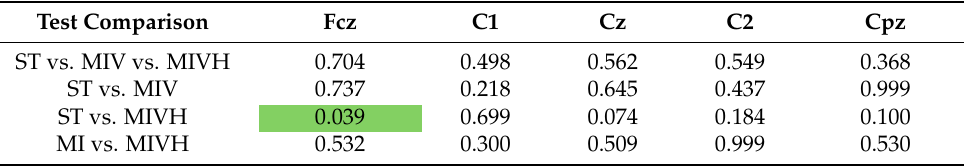
Table 4. p -Values along the comparison of ST, MIV and MIVH paradigms. The green values indicate significant statistical